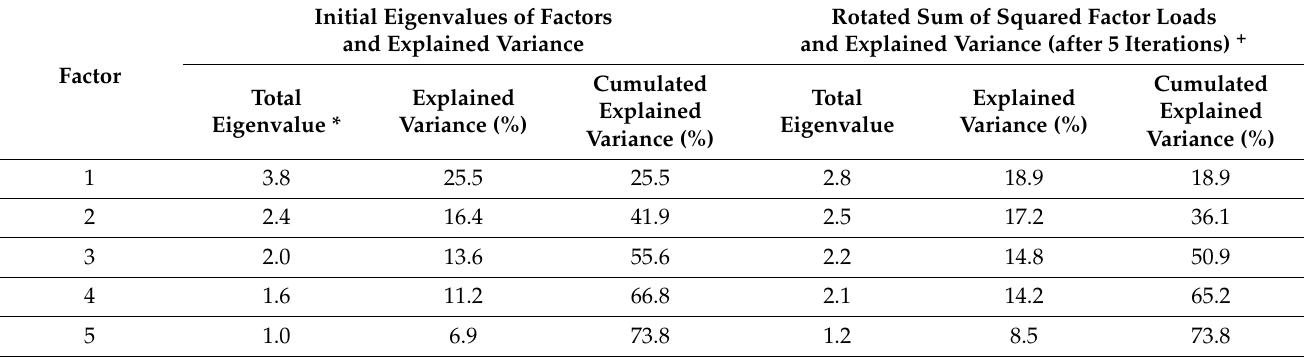
Table 3. Total variance explained by the five extracted factors (based on n = 156